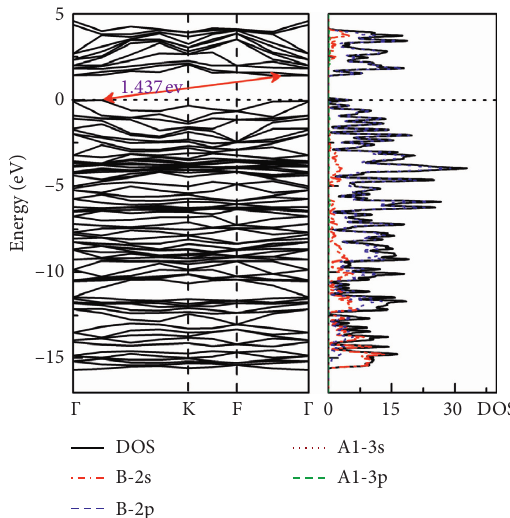
Figure 3: Electronic structure of Al doped